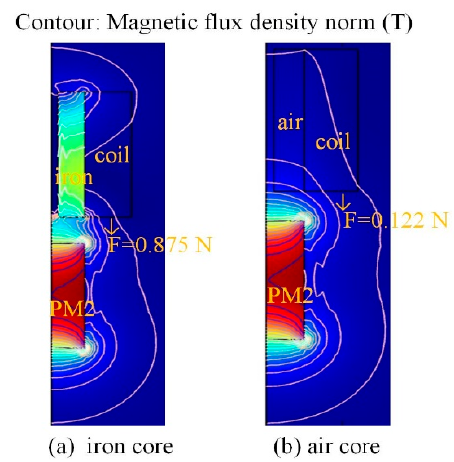
Figure 6. Magnetic flux contour under different magnetic permeabilities of the inserted core: ( a ) iron core; ( b ) air core.